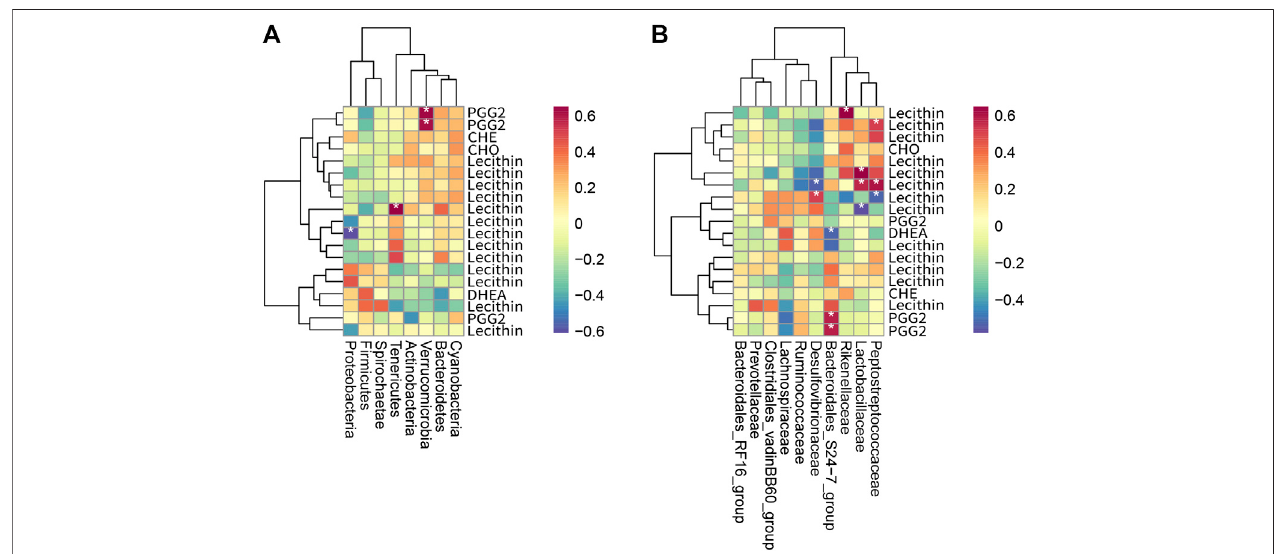
FIGURE9| Heatmapofthecorrelationbetweenmetabolitesandintestinalbacteria(n (cid:2) 3). (A) showsaheatmapofintestinalbacteriaanddifferentialmetabolitesat the phylum level, and (B) shows a heat map of intestinal bacteria and differential metabolites at the family level. The horizontal axis is intestinal bacteria, and the vertical axis is metabolites. Each grid represents the correlation coef fi cient between intestinal bacteria and metabolites. The color changes from white to red, indicating the positive correlation is from weak to strong; from white to blue indicates the negative correlation is from weak to strong. “ * ” means signi fi cant correlation ( p < 0.05); “ ** ” means extremely signi fi cant correlation ( p <